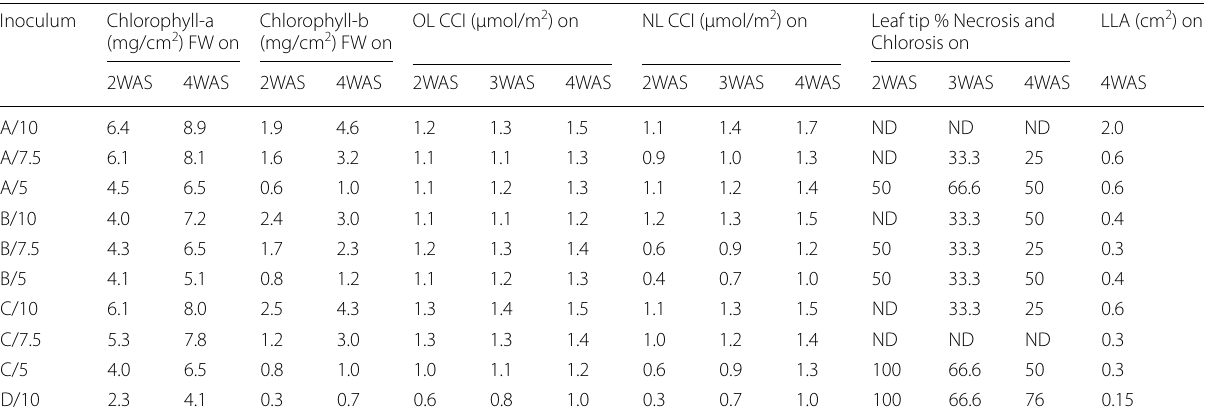
Table 8 Effect of PSB inoculum on in vitro rice physiological parameters